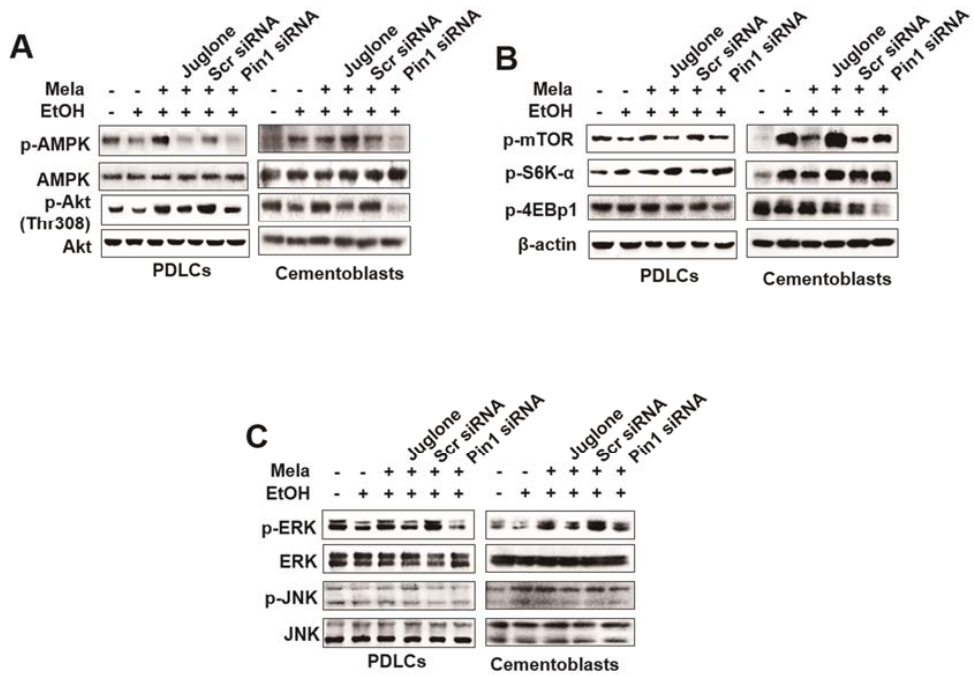
Figure 9. Involvement of AMPK, mTOR and MAPK pathway on effects of melatonin in EtOH-induced senescence or differentiation in PDLCs and cementoblasts. Cells are pretreated with juglone (50 nM) or PIN1siRNA (30 nM) and then incubated with melatonin (100 μ M) and EtOH (25 mM) for 60 min ( A , B ) and 45 min ( C ). Signal pathways was accessed by Western blot analysis. These data are representative of three independent experiments.